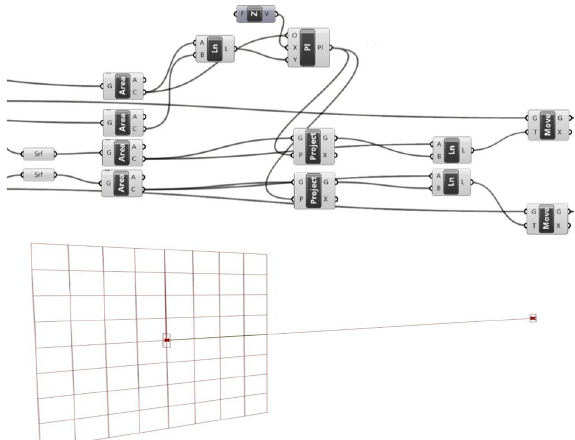
Figure 10: Algorithm for the projection of cross-sections on the vertical